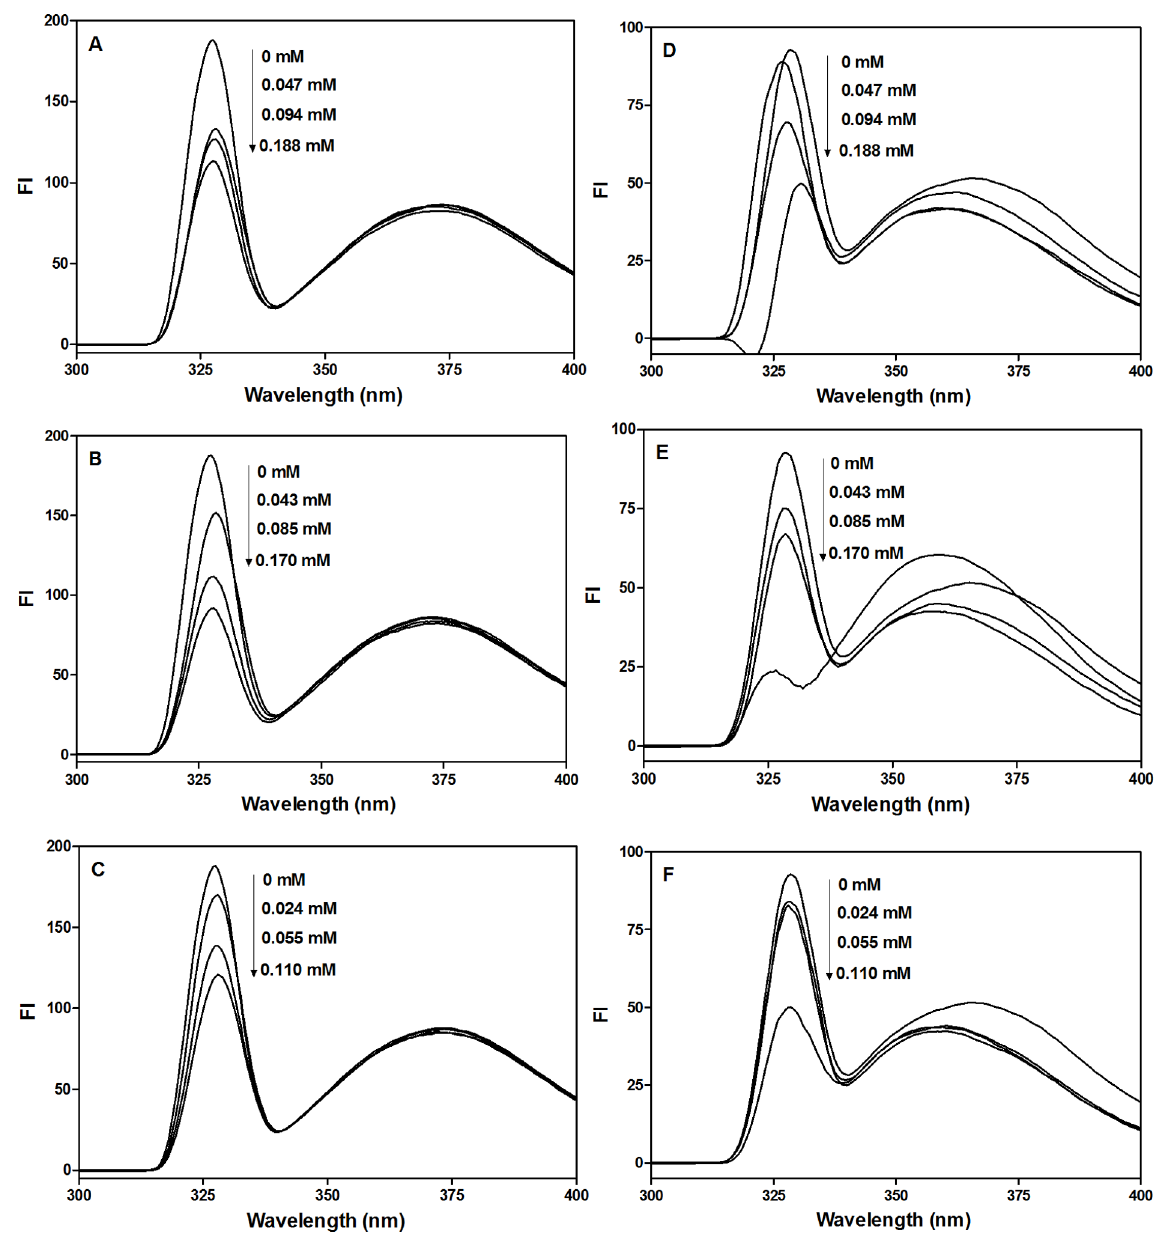
Figure 2. Emission spectra of ACE and renin proteins in the presence of peptides. Results of peptide-ACE interactions are showed in A (TF), B (LY), C (RALP), and that of peptide-renin interactions are D (TF), E (LY), F (RALP). In all cases l ex =280 nm.